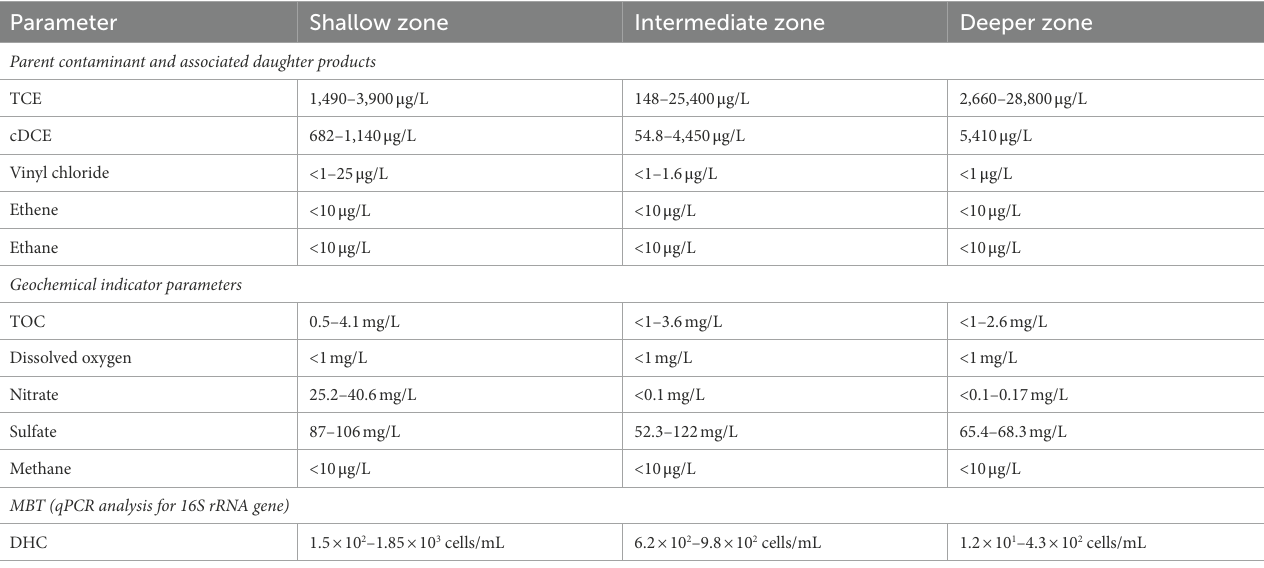
TABLE 1 Summary of baseline ranges for key parameters measured during the Assessment Stage from groundwater monitoring wells within the plume core.